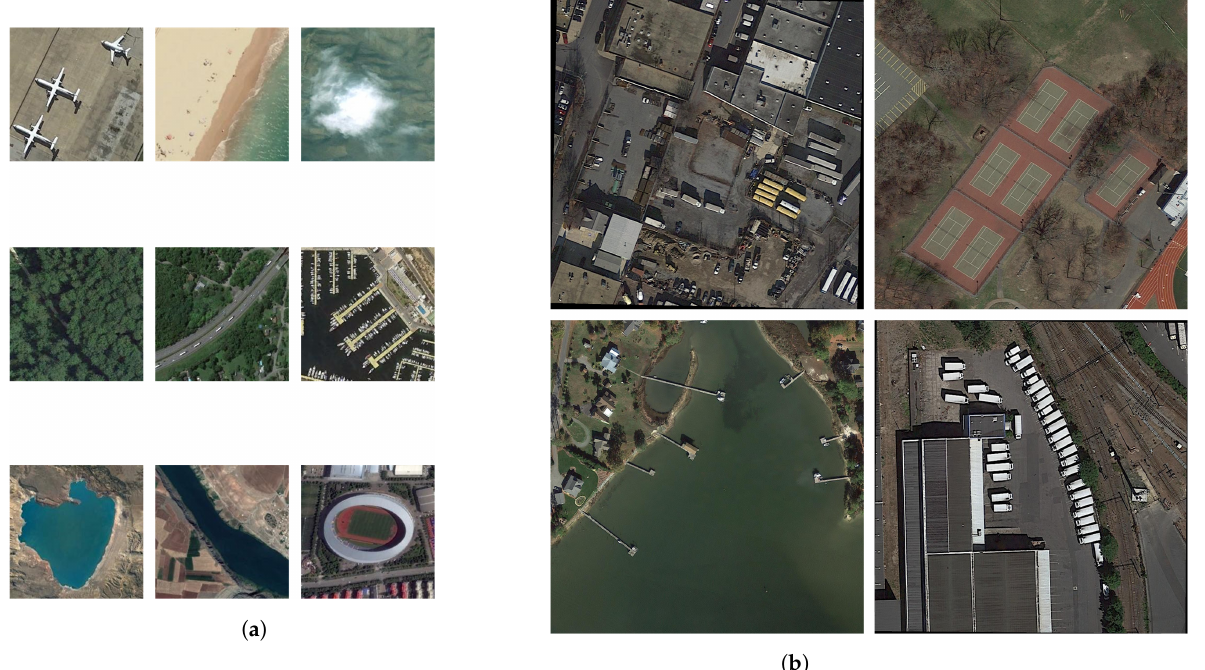
Figure 18. ( a ) Sample images from NWPU-RESISC45; ( b ) Sample images from